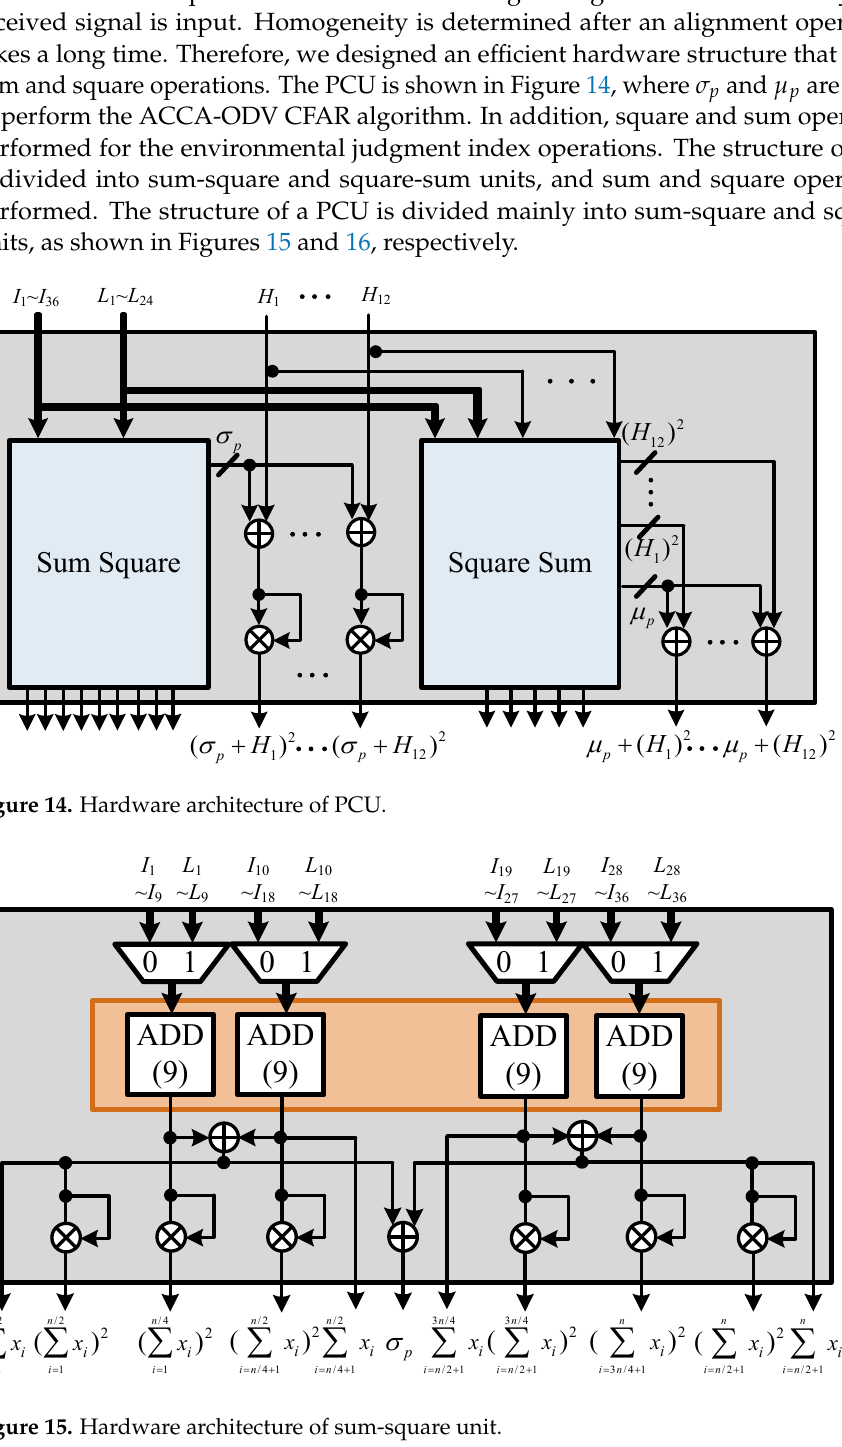
Figure 15. Hardware architecture of sum-square